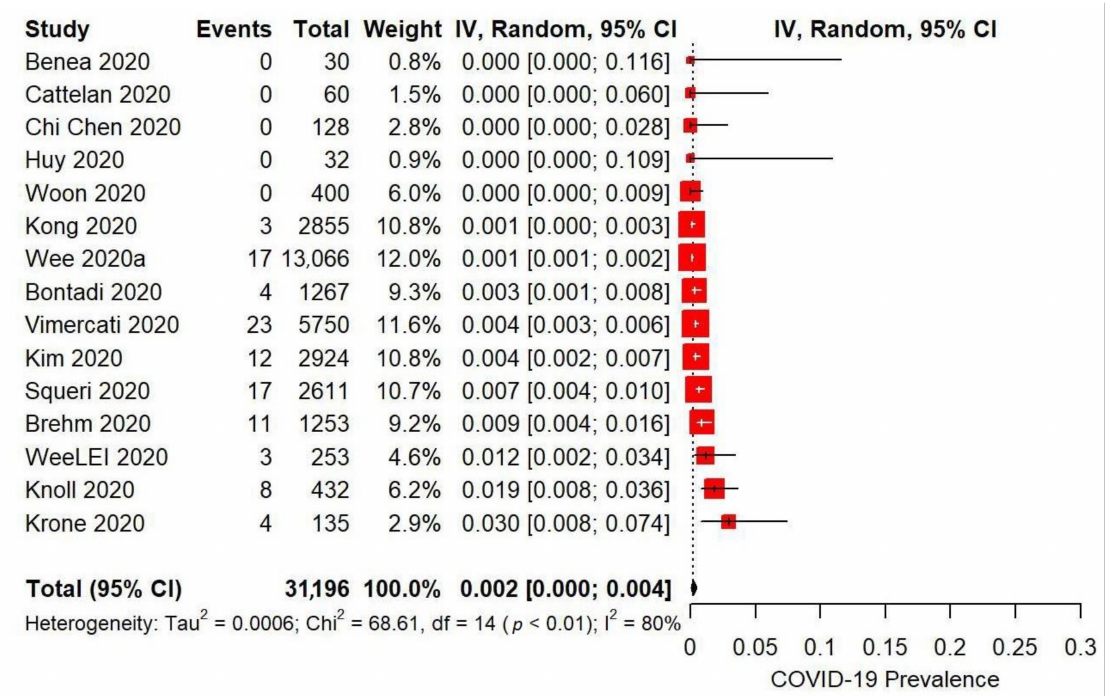
Figure 2. Meta-analysis of COVID-19 positivity rates in workplaces (14 hospitals and 1 nursing home) following the implementation of combined IPC measures between January and September 2020. Exact interventions implemented by